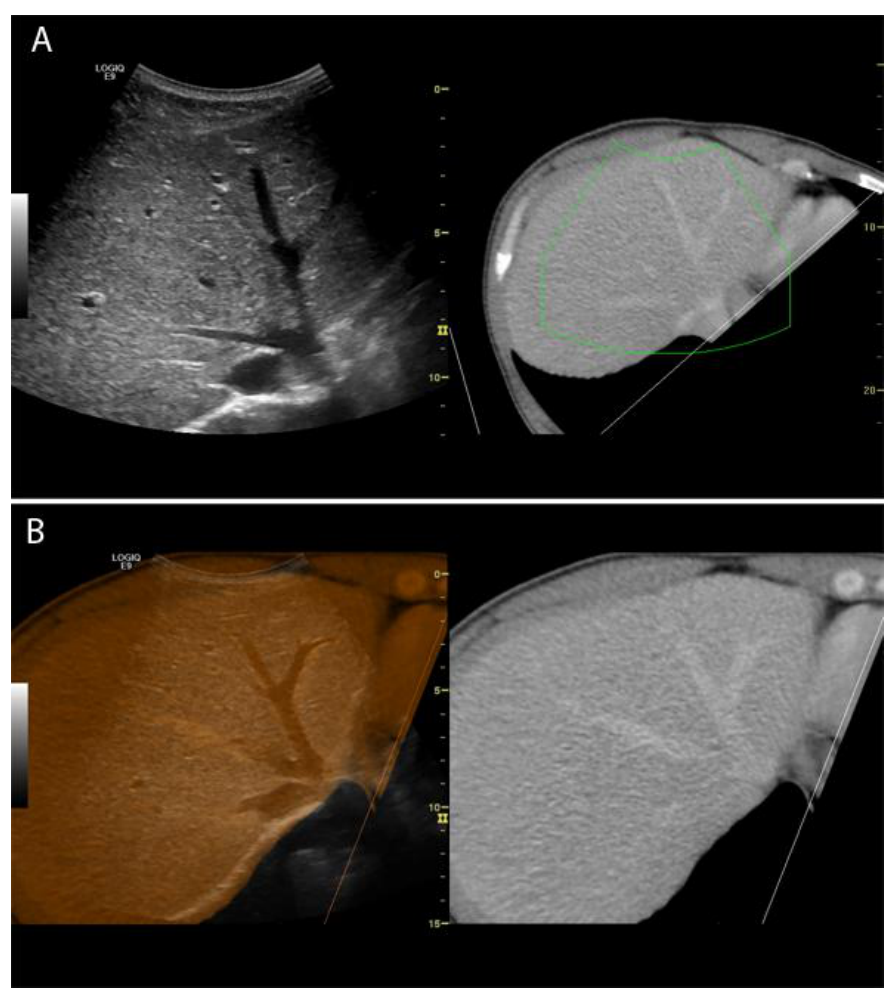
Figure 1. ( A ) Co-registered images of the liver shown side by side (ultrasound (US): left ; computed tomography (CT): right ); The green box indicates the scanning area ( B ) CT and US images of the liver overlaid ( left ) and corresponding CT-image ( right